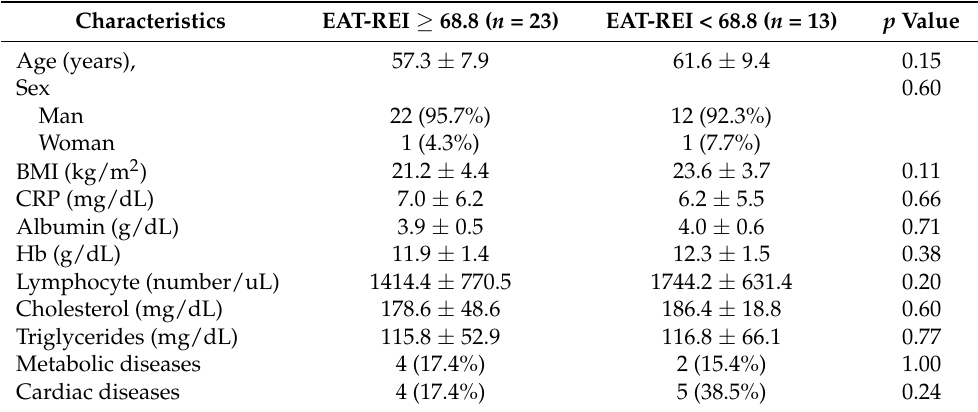
Table 4. Compare EAT-REI ratio with high and low patient